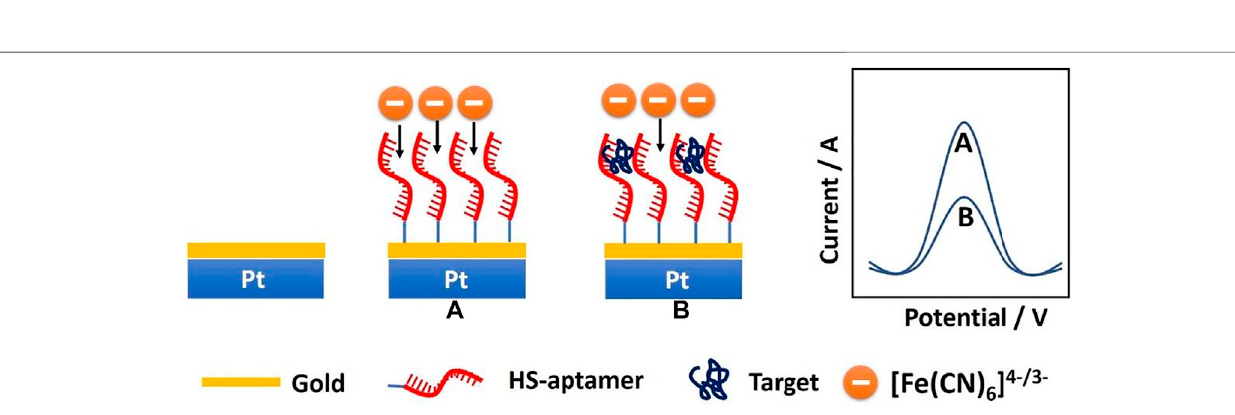
Frontiers in Chemistry |